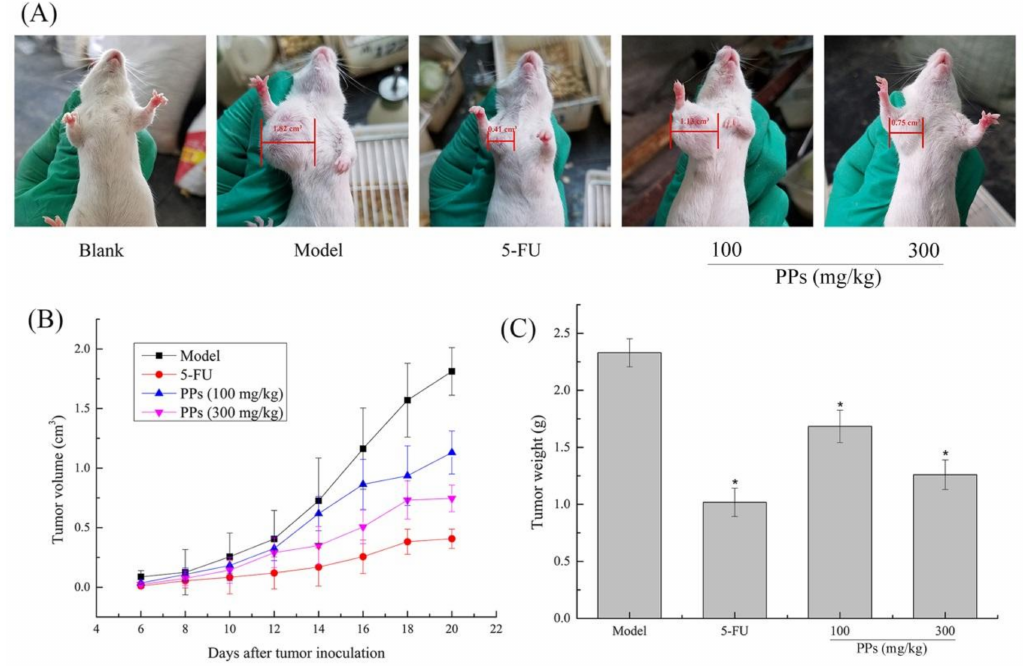
Figure 3. Antitumor effect of PPs on S180-bearing mice. The tumor size of mice after 21 days inoculation of S180 cells ( A ); Effect of PPs on the tumor growth velocity of mice ( B ); Effect of PPs on the tumor weight of mice ( C ). The tumor size in Figure 3A was measured using a vernier caliper. * p < 0.05 compared to model group was considered as